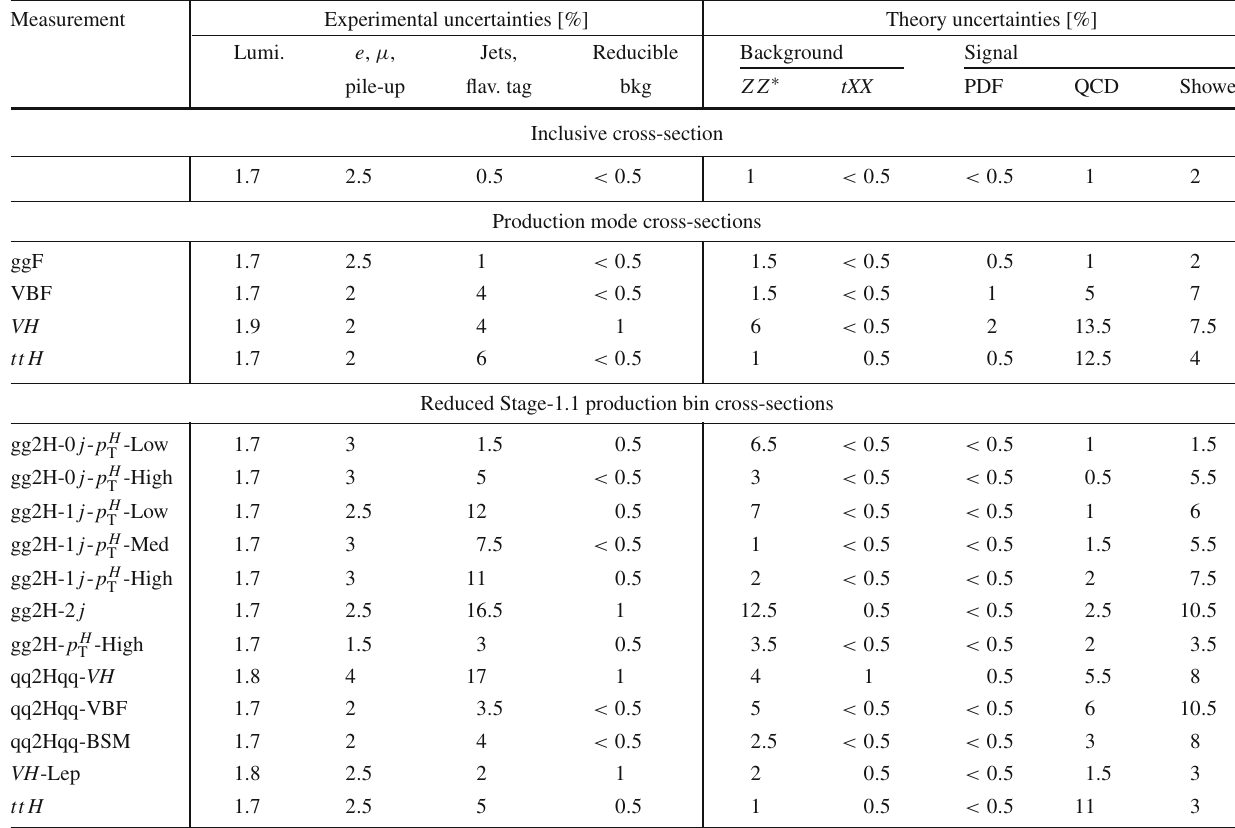
Table 6 The impact of the dominant systematic uncertainties (in per- cent) on the cross-sections in production bins of the Production Mode Stage and the Reduced Stage 1.1. Similar sources of systematic uncer- taintiesaregrouped together:luminosity(Lumi.),electron/muonrecon- struction and identification efficiencies and pile-up modelling ( e , μ , pile-up), jet energy scale/resolution and b -tagging efficiencies (Jets, flav. tag), uncertainties in reducible background (reducible bkg),